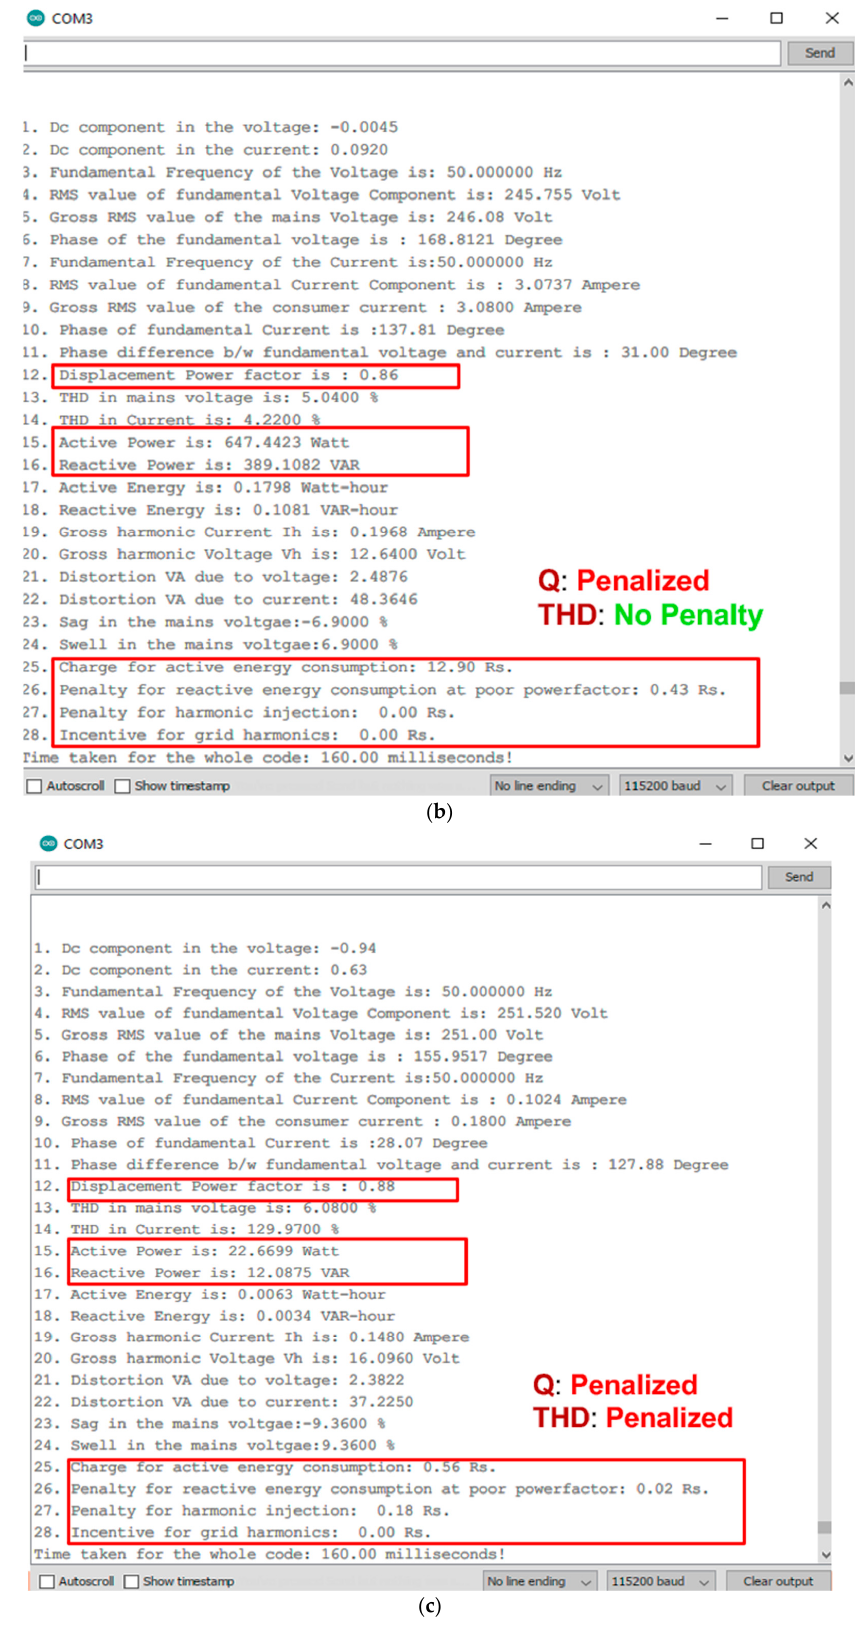
Figure 16. Measurements and penalties of three different loads: an ( a ) incandescent lamp, ( b ) electric iron box, and ( c ) laptop charger.